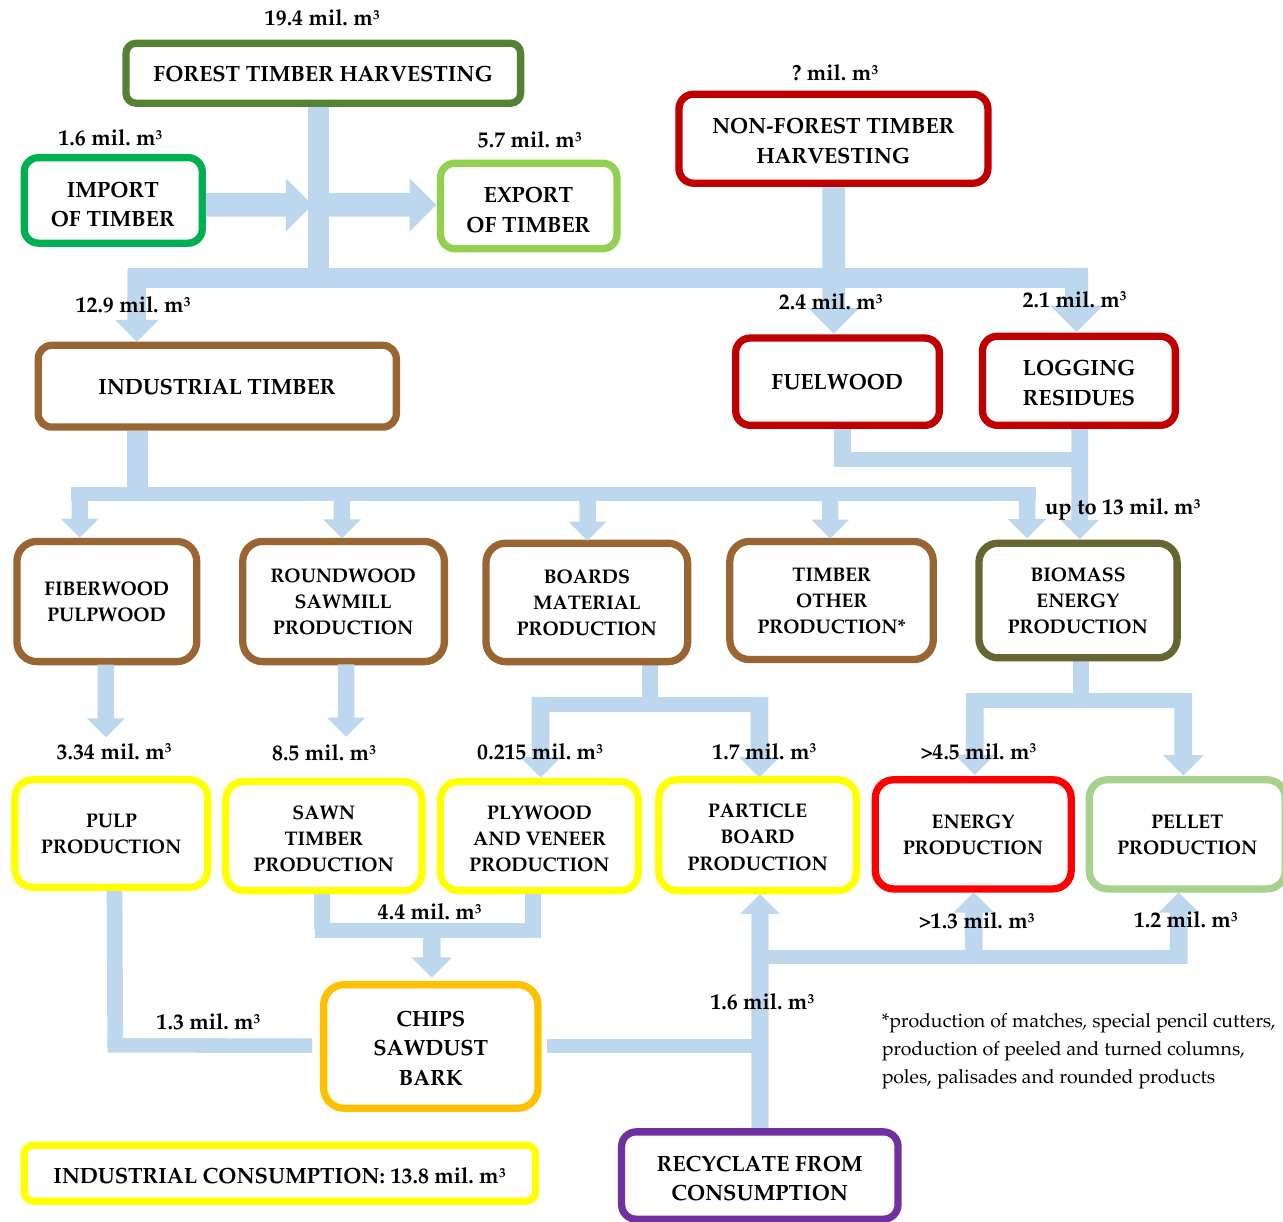
Figure 5. Timber flow model for the Czech